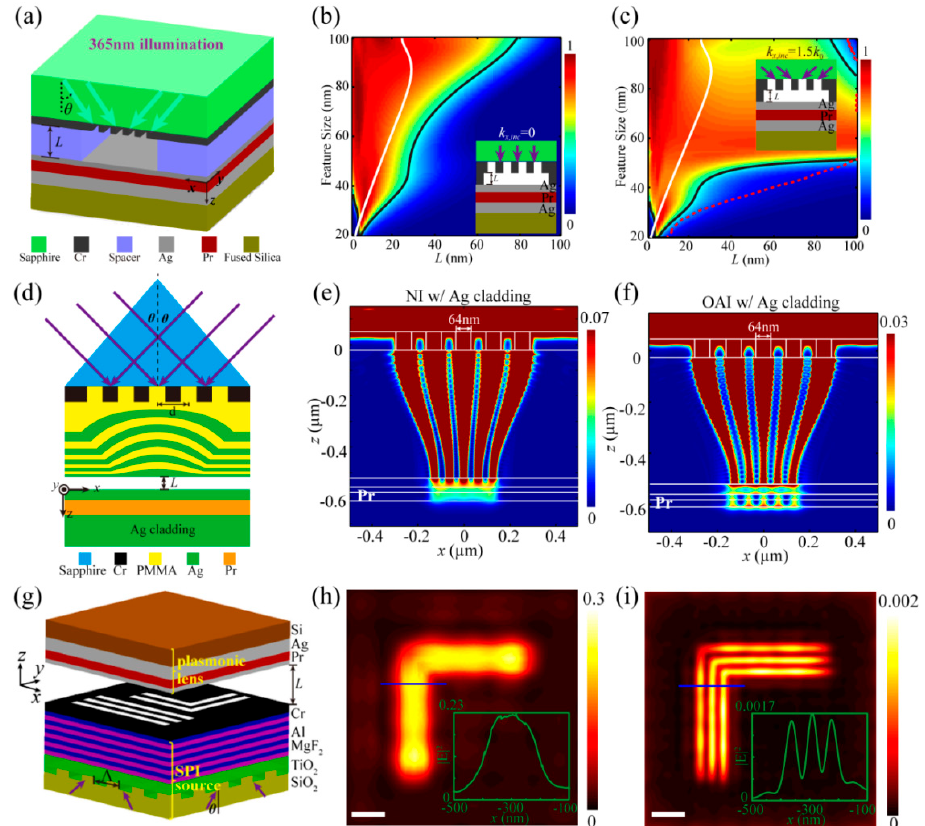
Figure 31. ( a ) Schematic structure of SPPs cavity lens imaging under off-axis illumination (OAI); Imaging contrast of dense line pattern as a function of air working distance and feature size in the case of ( b ) conventional near-field imaging and ( c ) plasmonic cavity lens with OAI (illumination light k x ,inc = 1.5 k 0 ); ( d ) Schematic structure of planar hyperlens imaging under OAI; ( e , f ) are the simulation results of the structure in (d) under normal and off-axis illumination, respectively; ( g ) Schematic structure of plasmonic cavity lens imaging under surface plasmon illumination (SPI); ( h , i ) are simulated imaging results of the L-shape feature under normal and off-axis illumination, respectively. The air working distance in (e,f,h,i) is 40 nm. Reproduced from: (a–c), [25], Copyright © 2015, NGP; (d–f), [114], Copyright © 2014, Springer; (g–i), [115], Copyright © 2015, Springer.